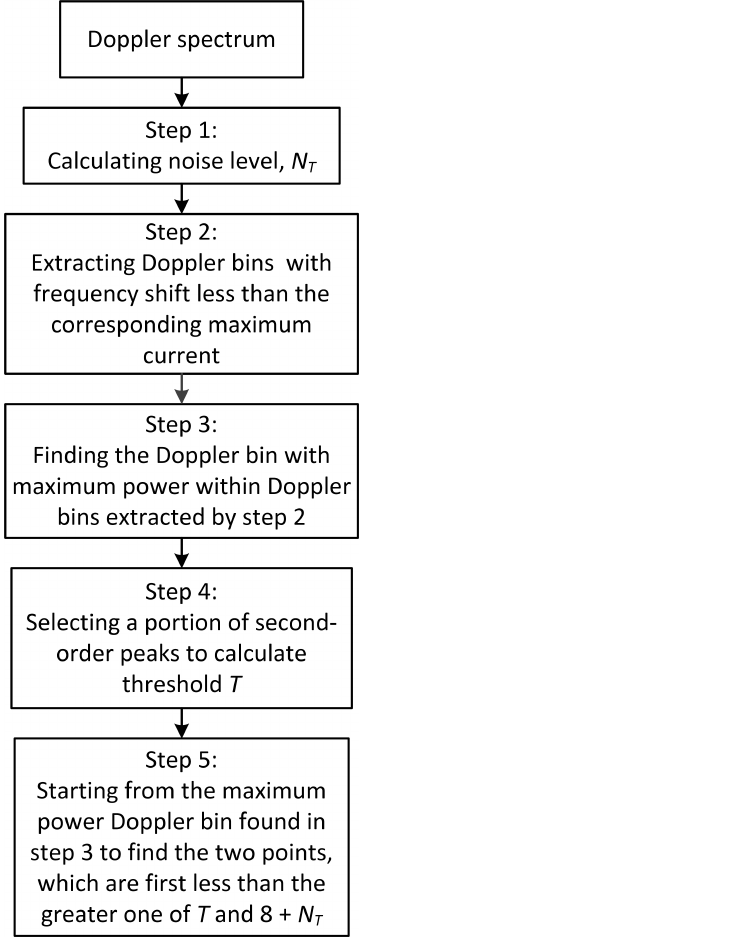
Figure 1. The processing flow of the second-order spectra-based (SSB) method.